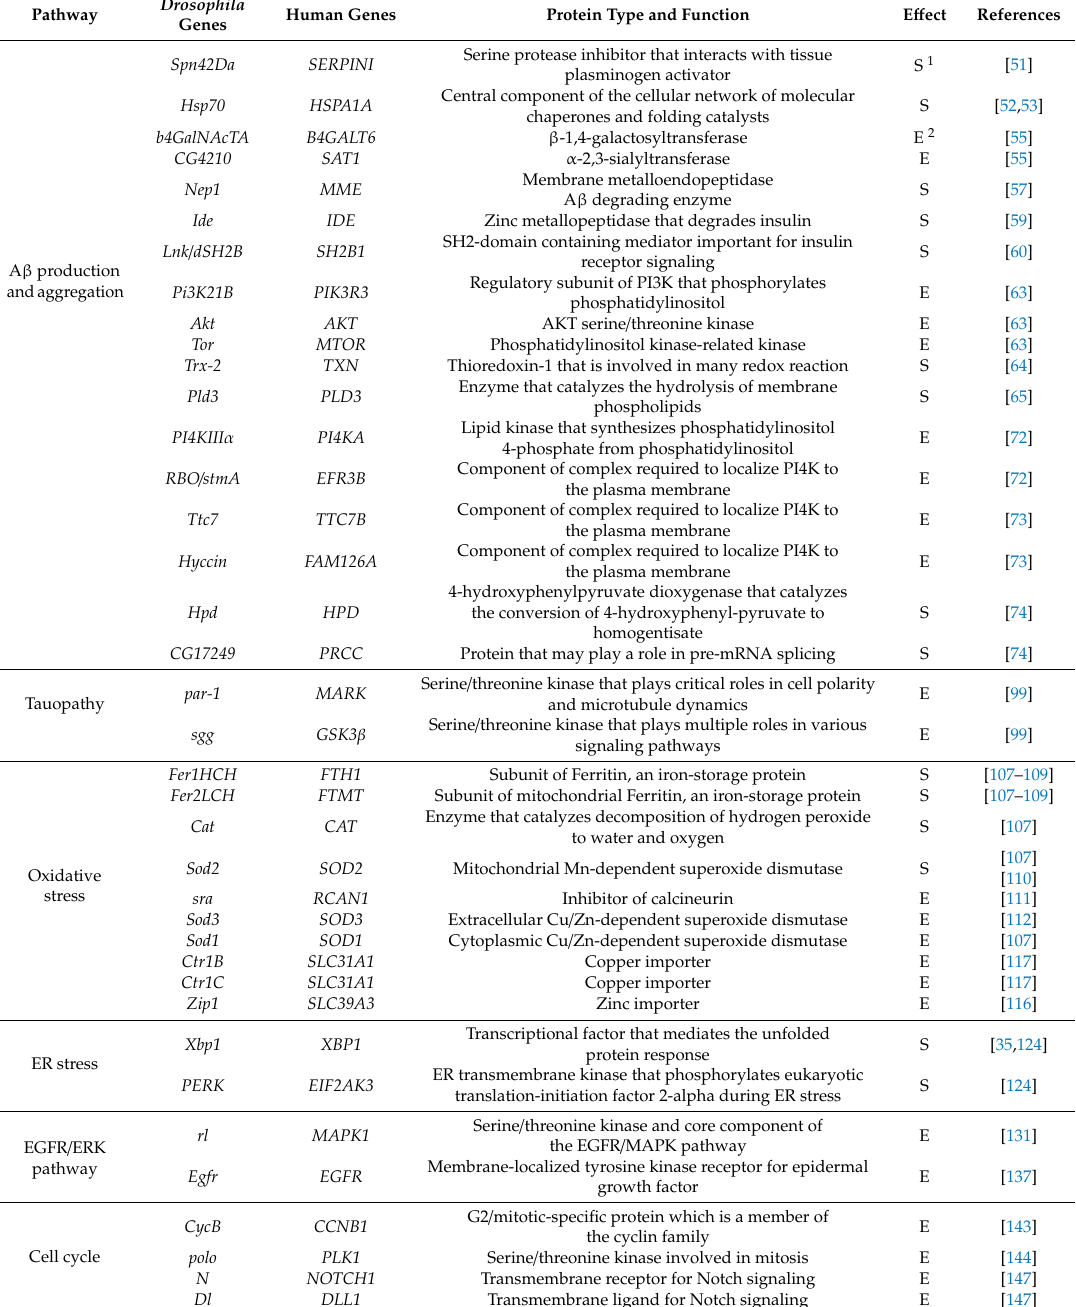
Table 1. Genetic modifiers of amyloid precursor protein (APP) or A β -based Drosophila Alzheimer’s disease (AD)